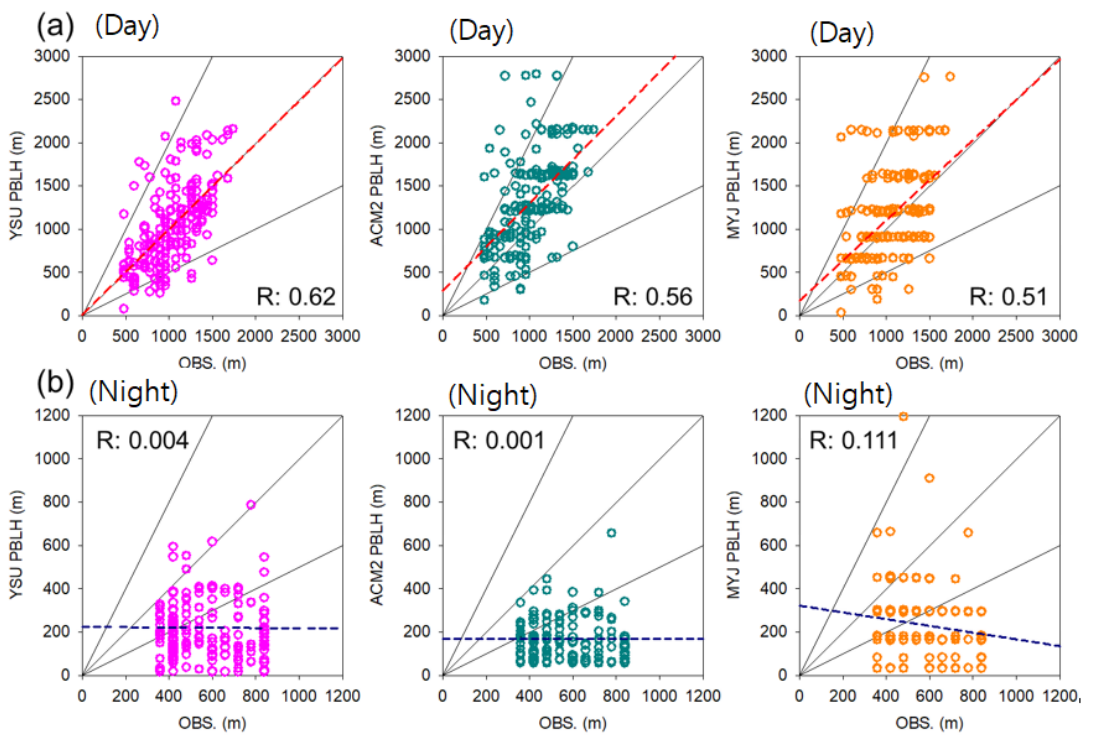
Figure 6. Scatter diagrams of simulated and observed PBLHs at P1 (Gwanak). PBL schemes included YSU (pink), ACM2 (blue), and MYJ (orange) parameterizations for ( a ) daytime (09:00–18:00 LST) and ( b ) nighttime (21:00–6:00 LST) simulations.